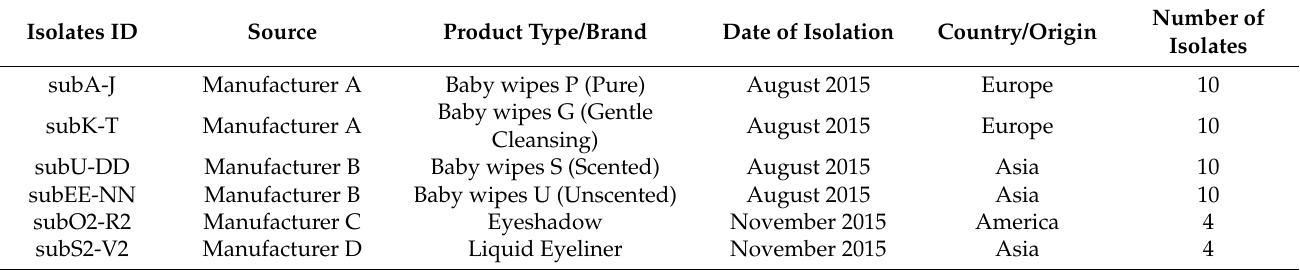
Table 1. Isolates from baby wipes and cosmetics, manufacturer source, product information, isolation date, and corresponding metadata of strains used in this